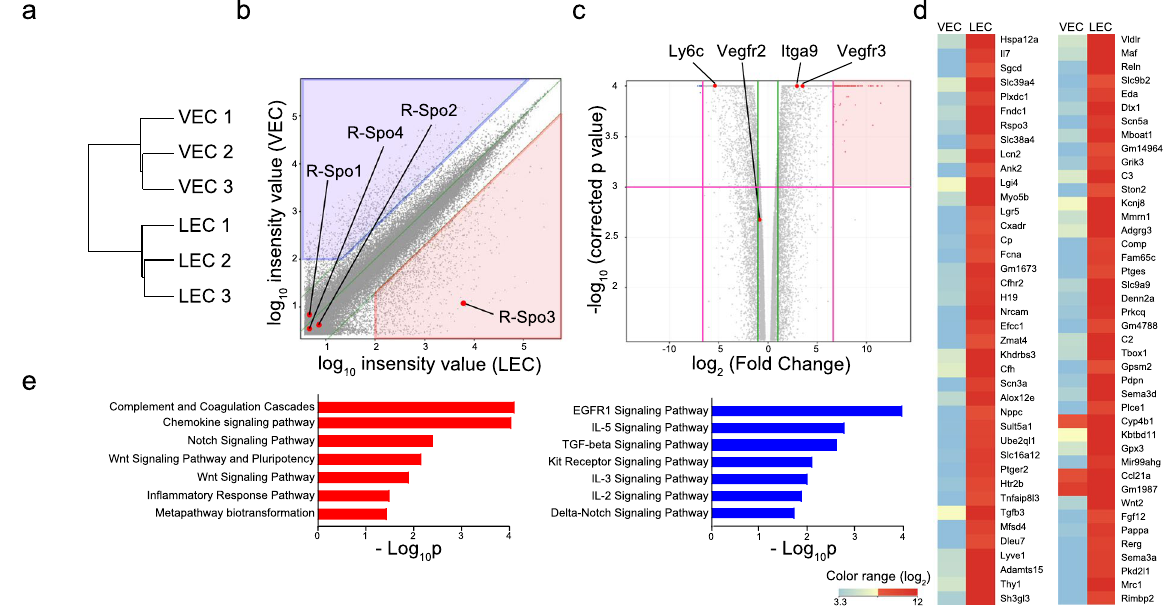
Figure 4. Transcriptome analysis of intestinal LECs. The transcriptome of VECs and LECs sorted from the small intestines was analyzed (n = 3/group). ( a ) Hierarchical clustering using the Euclidean distance of each samples. ( b ) Scatter plot shows the expression levels of each entity in LECs and VECs. The list of 1226 entities that were up-regulated (fold change > 5 and expression level in LECs > 100; red shaded) and 975 entities that were down-regulated (fold change > 5 and expression level in VECs > 100; blue shaded) in LECs is shown in Supplementary Table 2. ( c ) Volcano plots with relative differences in expression levels between VECs and LECs and the p value of each entity. Green lines indicate fold change < 0.5 or > 2, and magenta lines indicate fold change < 0.01 or > 100 and p < 0.001. ( d ) A heatmap shows the expression levels of highly LEC-specific genes (fold change > 100 and p < 0.001; red shaded in Fig. 3c). ( e ) Biological pathways from WikiPathways were assigned to each entity selected in ( b ). The bar charts display the negative log of the enrichment p values for each pathway enriched in LECs (red) or VECs